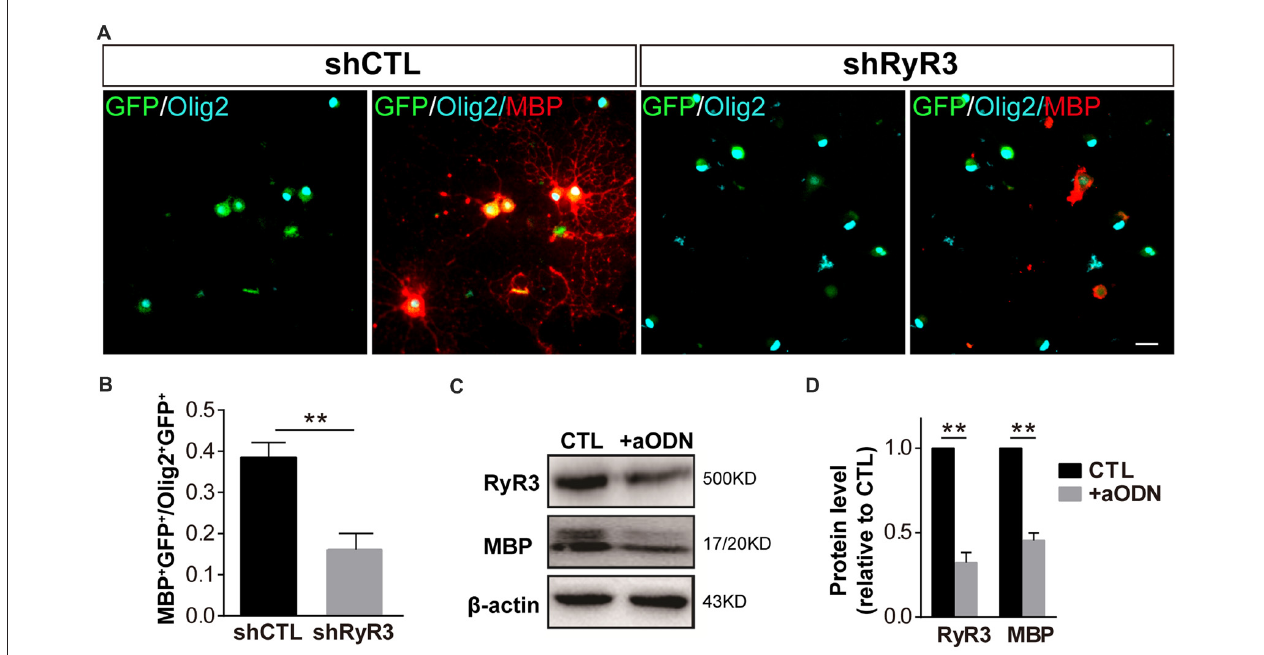
FIGURE 4 | Knockdown of RyR3 in OPCs results in inhibition of OPC differentiation. (A,B) Gene knockdown of RyR3 with shRNA interference mediated by lentivirus infection showed fewer MBP-positive mature OLs after 48 h of differentiation. GFP was expressed in lentivirus-infected cells ( ∗∗ p < 0.05). Scale bar 20 µ m. (C,D) Knockdown of RyR3 in OPCs by antisense oligonucleotide (+aODN) resulted in less expression of myelin basic protein (MBP; ∗∗ p < 0.05).